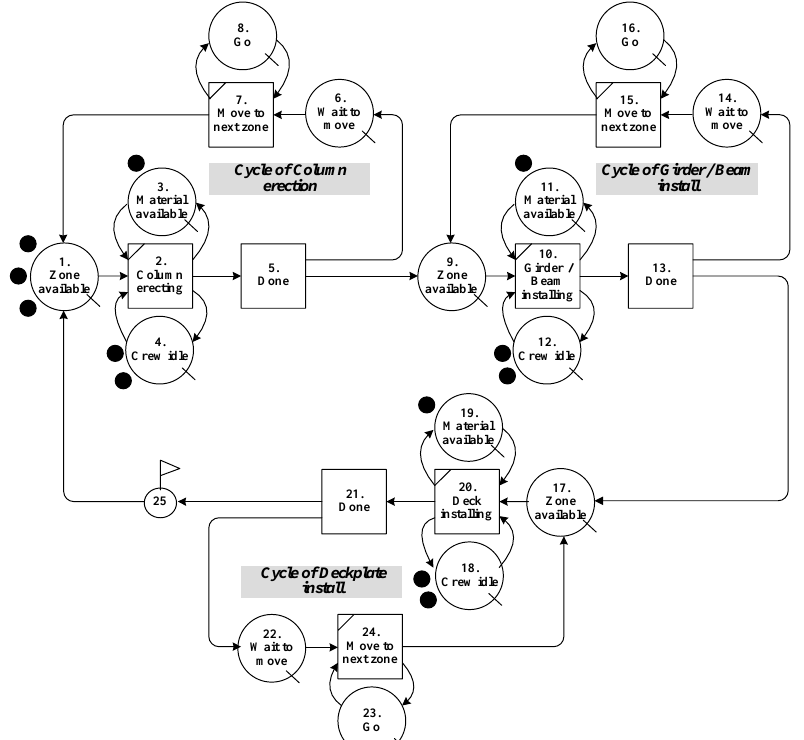
Fig. 4. SCHEME for steel structure